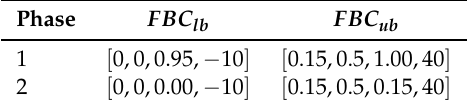
Table 3. Final boundary conditions (FBC) of the optimization problem.